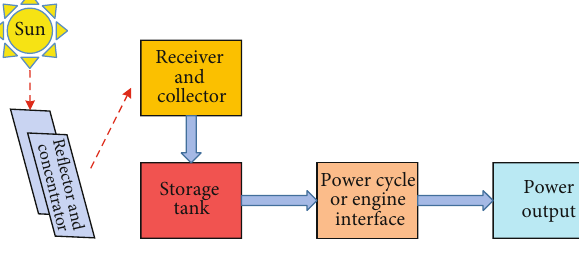
Figure 1: Concept of the CSP technology.